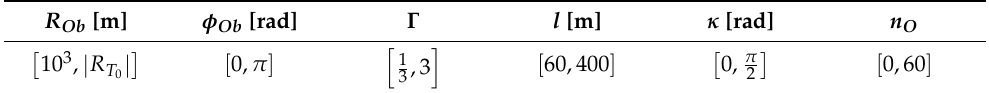
Table 2. The rectangle